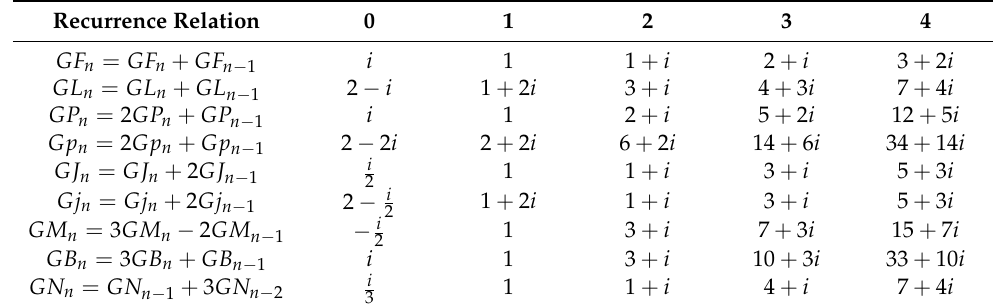
Table 3. Some recurrences and their